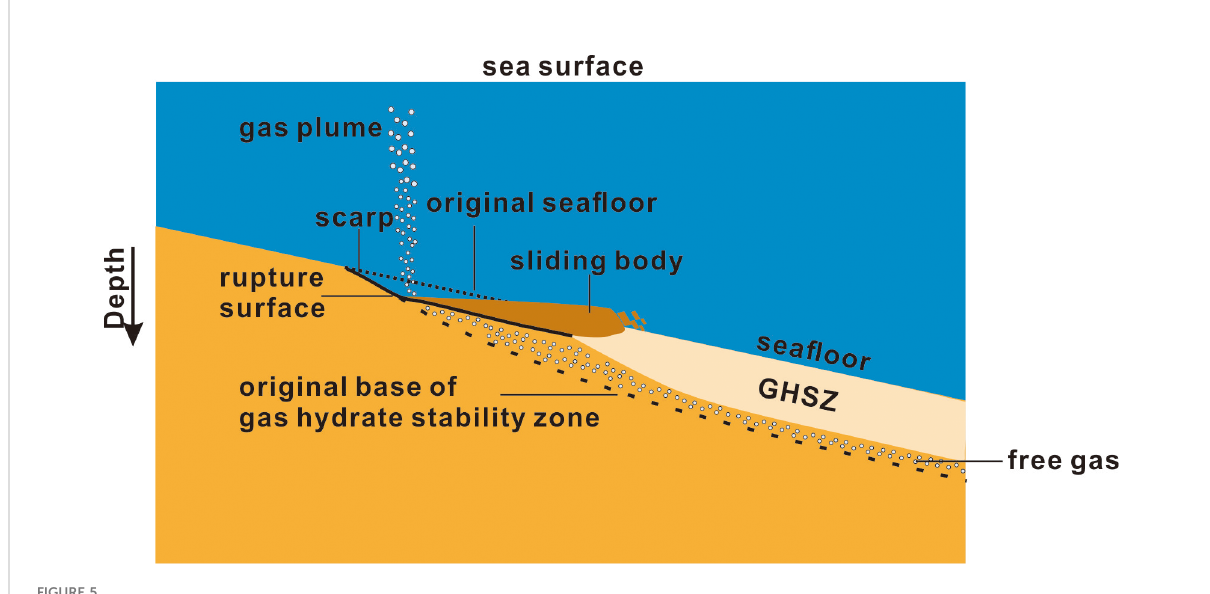
FIGURE 5 Schematic of submarine landslide caused by gas hydrate dissociation [modi fi ed from Dickens